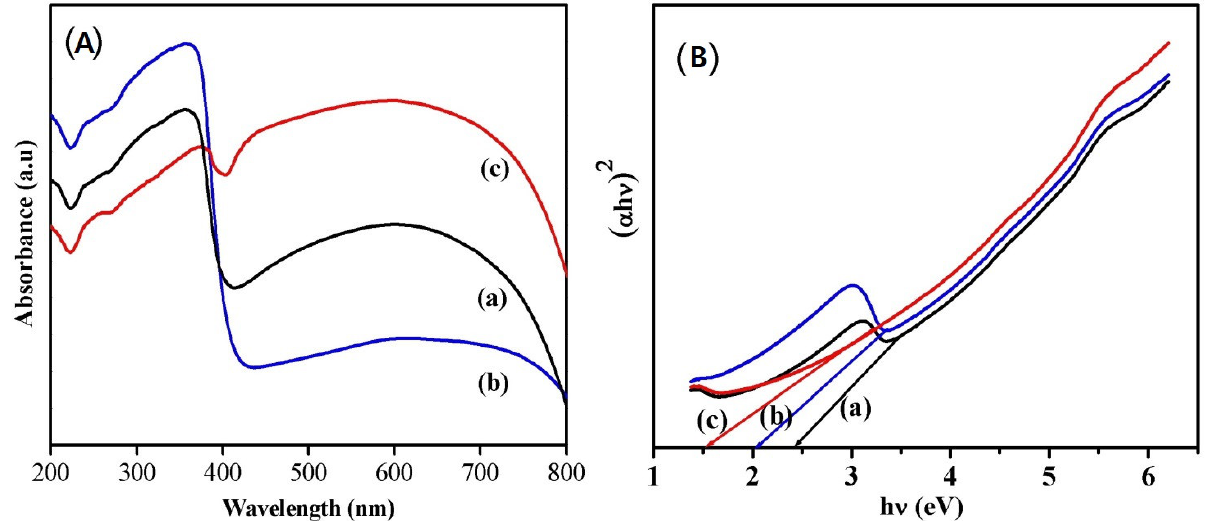
Figure 4. ( A ) UV–vis absorption spectra and Tauc’s plot ( B ) of phthalic acid ( a ), ( b ) citric acid, and ( c ) oxalic acid assisted WO 3 nanoparticles.